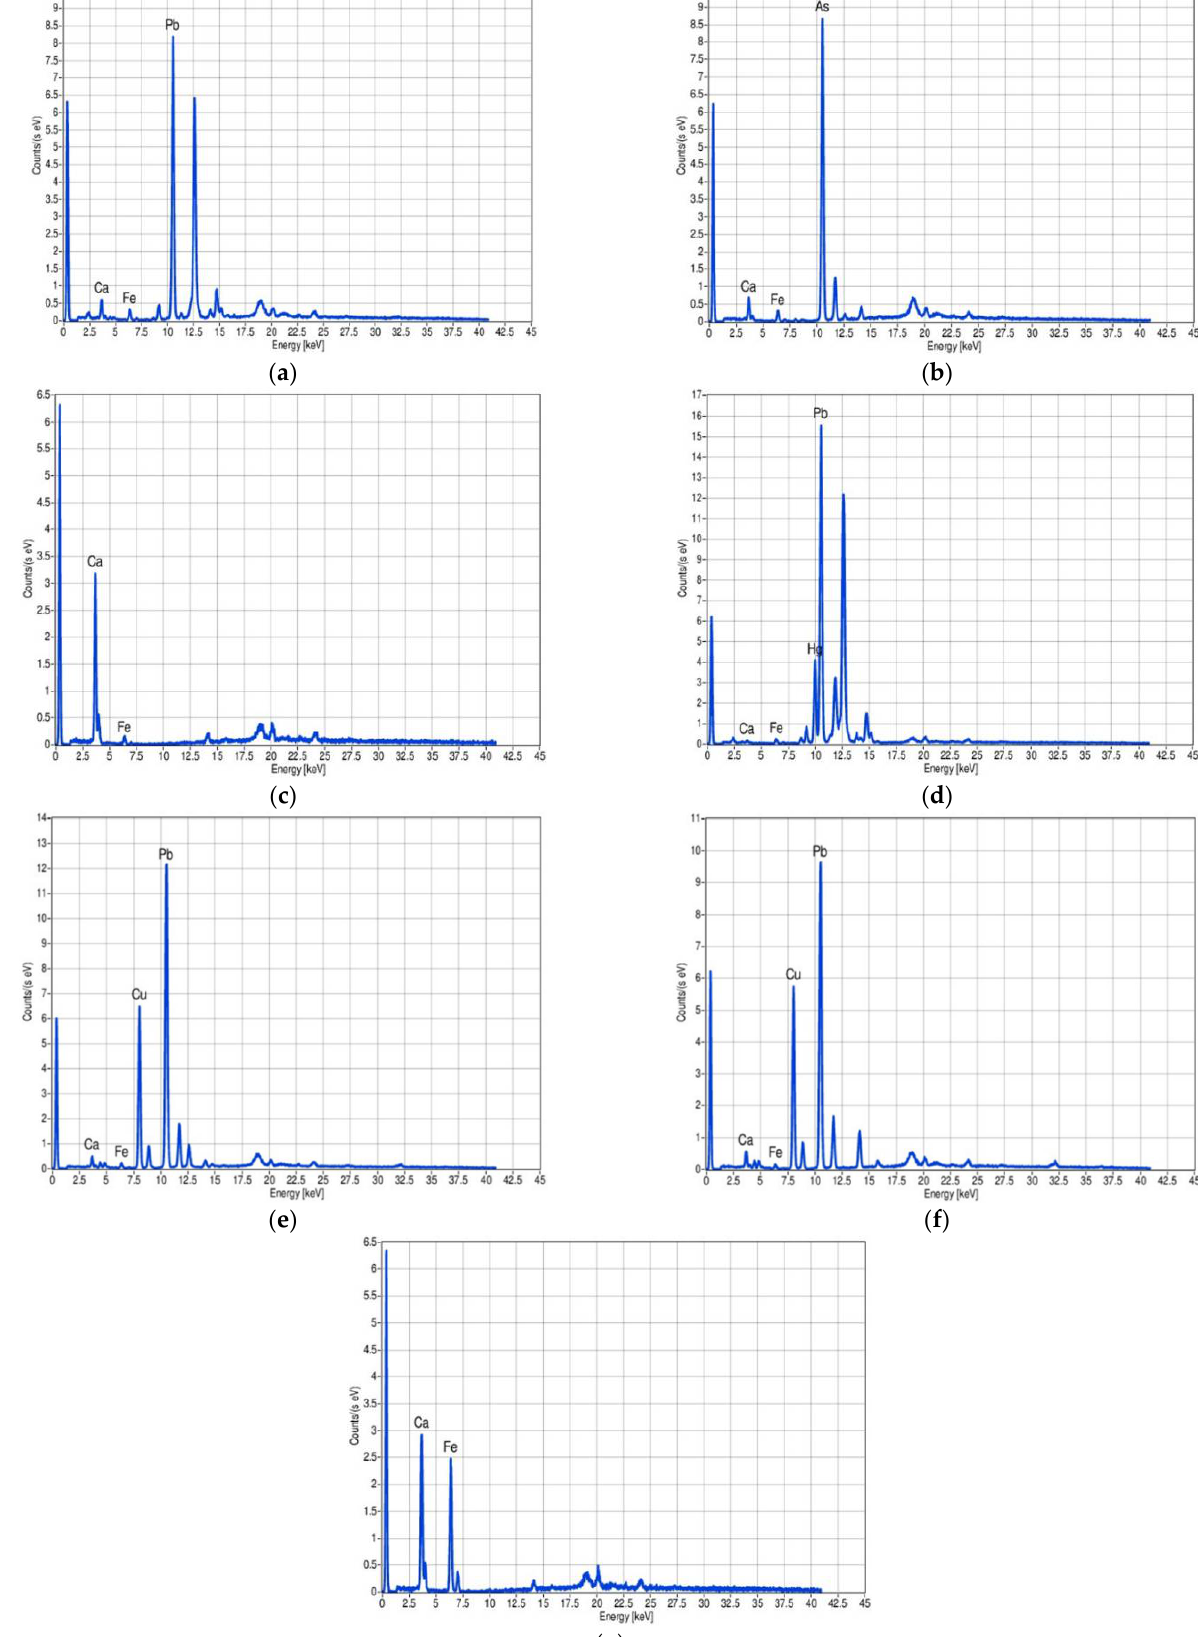
Figure 9. Chemical elements present in the painting materials.